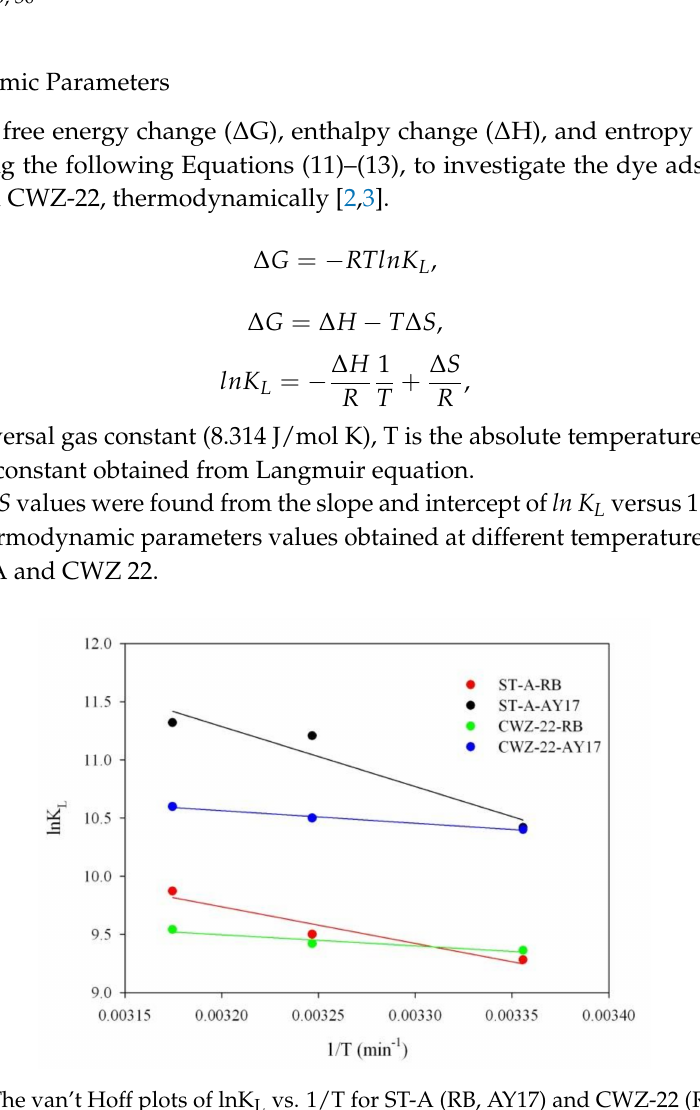
Figure 9. The van’t Hoff plots of lnK L vs. 1/T for ST-A (RB, AY17) and CWZ-22 (RB, AY17). Table 7. Thermodynamic parameters for RB and AY17 adsorption on ST-A and